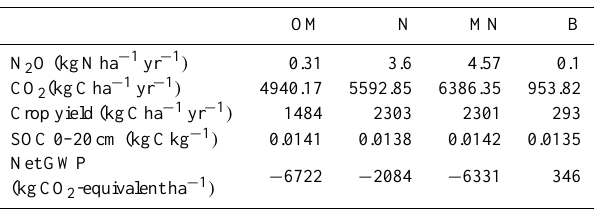
Table 3. Modeled N 2 O and CO 2 fluxes, crop yields, SOC values and net GWP under four different treatments of summer maize in the